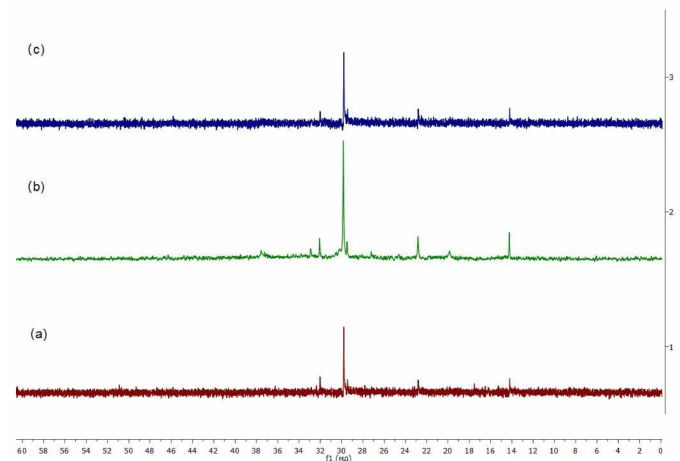
Figure 10. 13 C NMR spectra of the bitumen ( a ), tar ( b ) and the compounded bitumen ( c ).